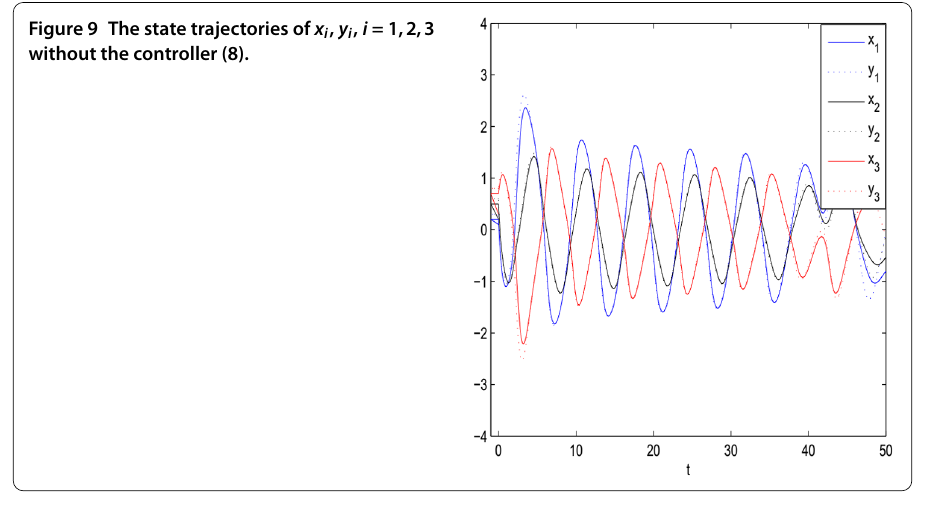
Figure 9 The state trajectories of x i , y i , i = 1,2,3 without the controller (8).